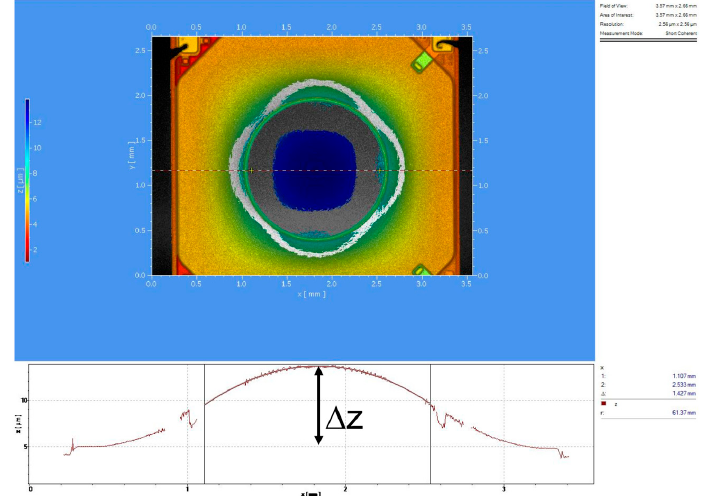
Figure 8. Results of a topographic measurement performed with a Polytec Micro-System Analyzer MSA 500 on a Tlens ® actuated with 20 V. On the z-axis, in false colors is height reached by the deformed surface of the lens. The maximum height variation in the center of the pupil is Δ z ~ 8.8 µm.